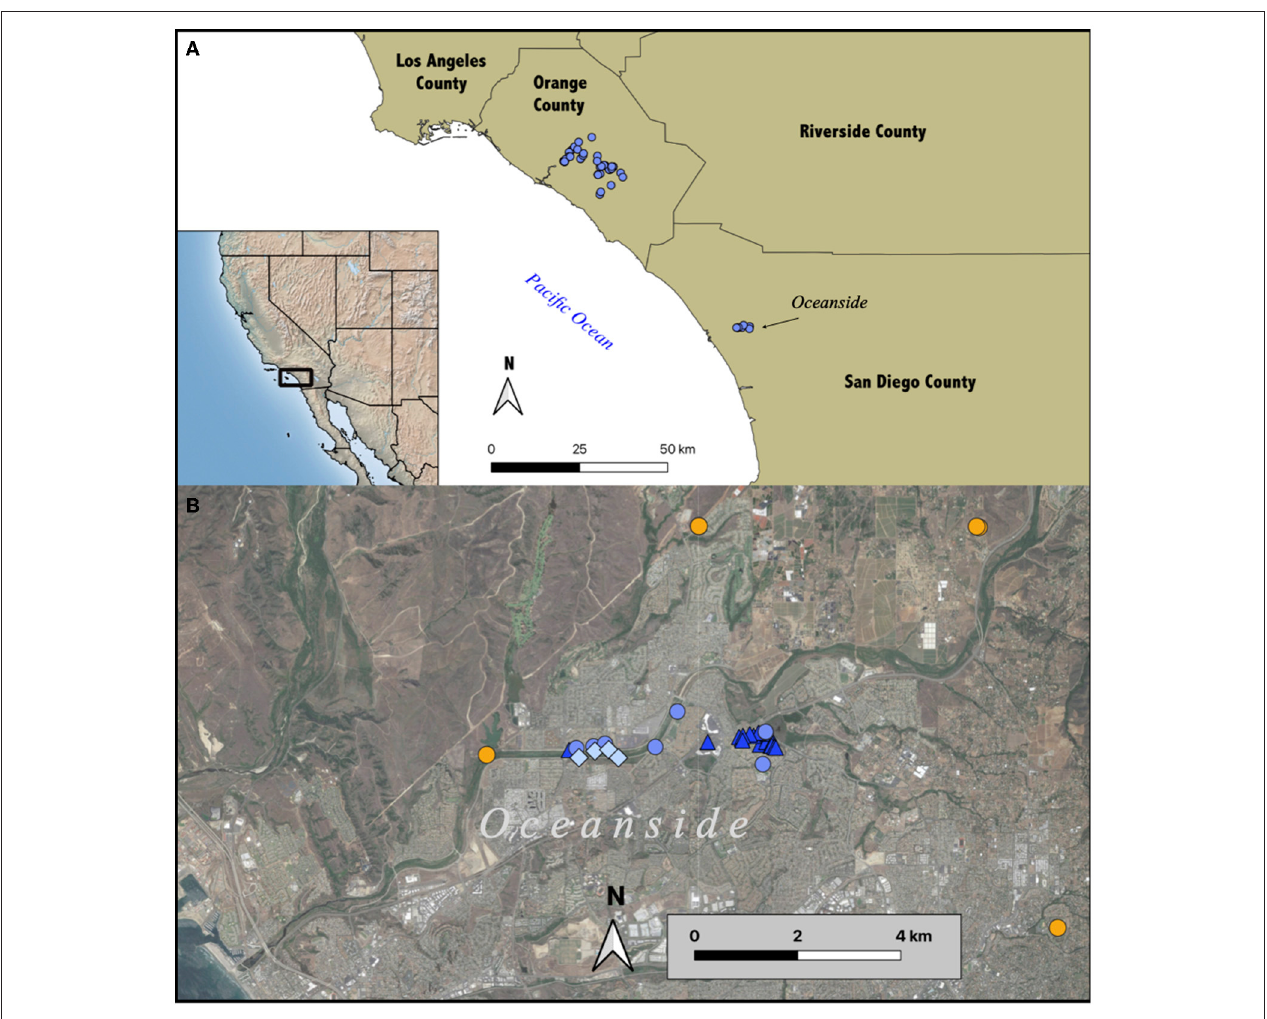
FIGURE 1 | Distribution of Aspidoscelis sonorae in Southern California. (A) Confirmed A. sonorae in Orange and San Diego counties based on research-grade iNaturalist observations. (B) The distribution of the invasive A. sonorae (medium blue circles for iNaturalist observations; dark blue triangles for field observations by authors), probable A. sonorae based upon iNaturalist observations that cannot be confidently identified to species (pale blue diamonds), and native Orange-throated Whiptails ( A. hyperythrus ; orange